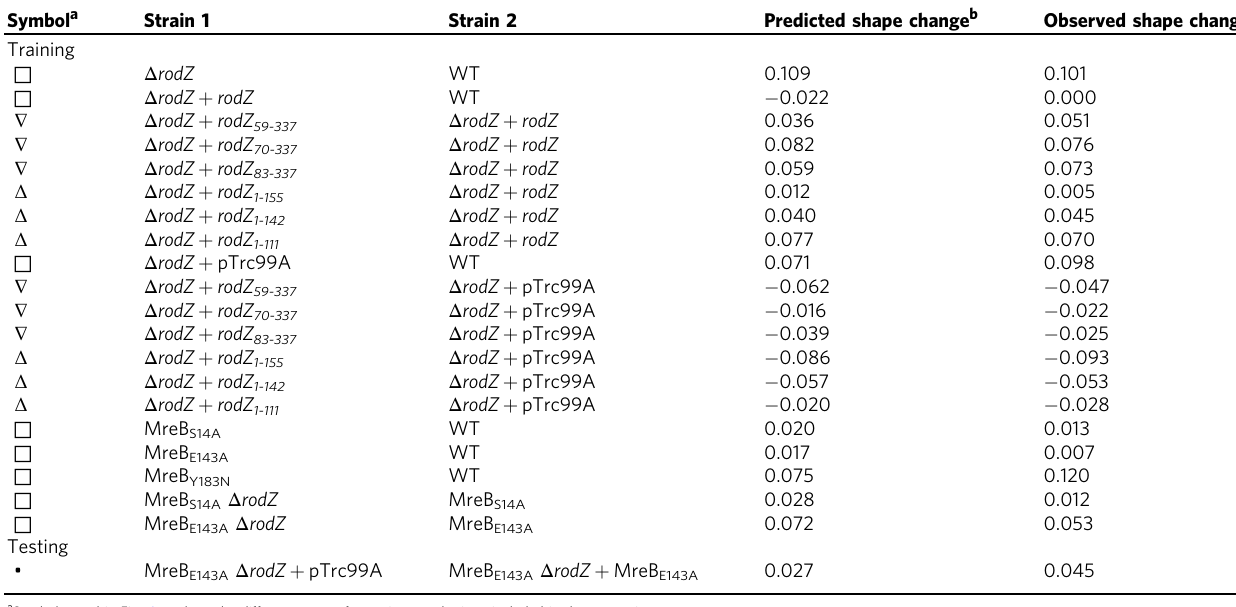
a Symbols used in Fig. 4 to show the different types of genetic perturbations included in the regression b Predicted change in cell shape ( Δ IDD = IDD strain1 − IDD strain2 ) is predicted from the regression model c Observed change in cell shape is from 3D measurements of